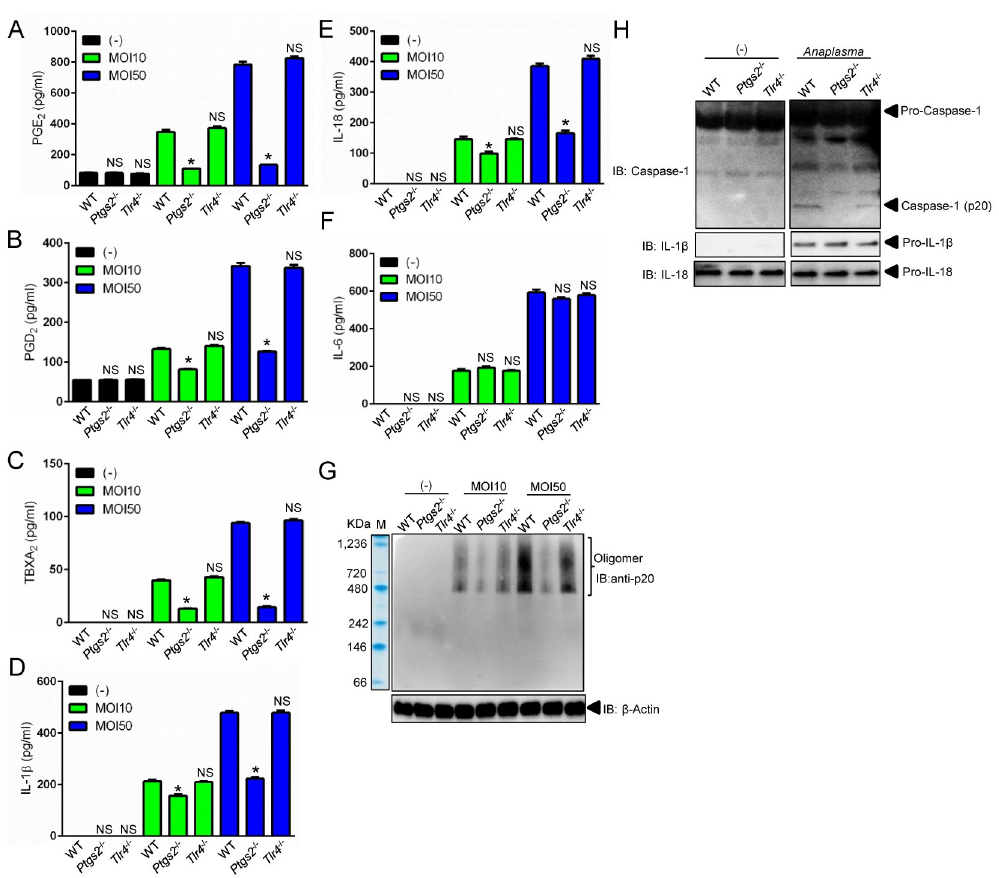
Fig 6. COX2 modulates NLRC4 inflammasome activity upon A . phagocytophilum infection. BMDMs (1 x10 6 cells) from wildtype (WT), Tlr4 - and COX2 ( Ptgs2 )-deficient mice were infected with A . phagocytophilum (MOI 10/ 50) for 18 hours. The levels of (A) PGE 2 , (B) PGD 2 , (C) TBXA 2, (D) IL-1 β , (E) IL-18 and (F) IL-6 were measured by ELISA in the cell culture supernatants. (G) Caspase-1 (p20) native gel and (H) immunoblotting (IB). β -Actin, pro-IL- 1 β and pro-IL-18 detected in lysates. One way ANOVA-Tukey. * P < 0.05. NS – not significant. (-)